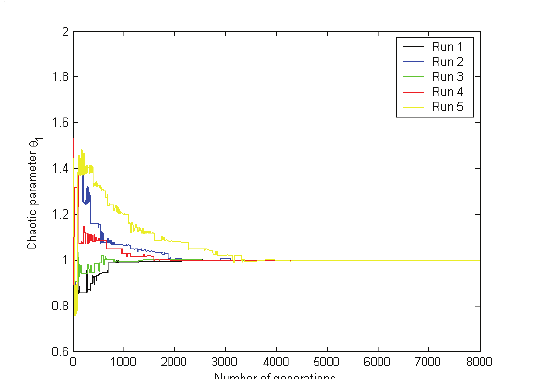
(cid:84) for the first five 4